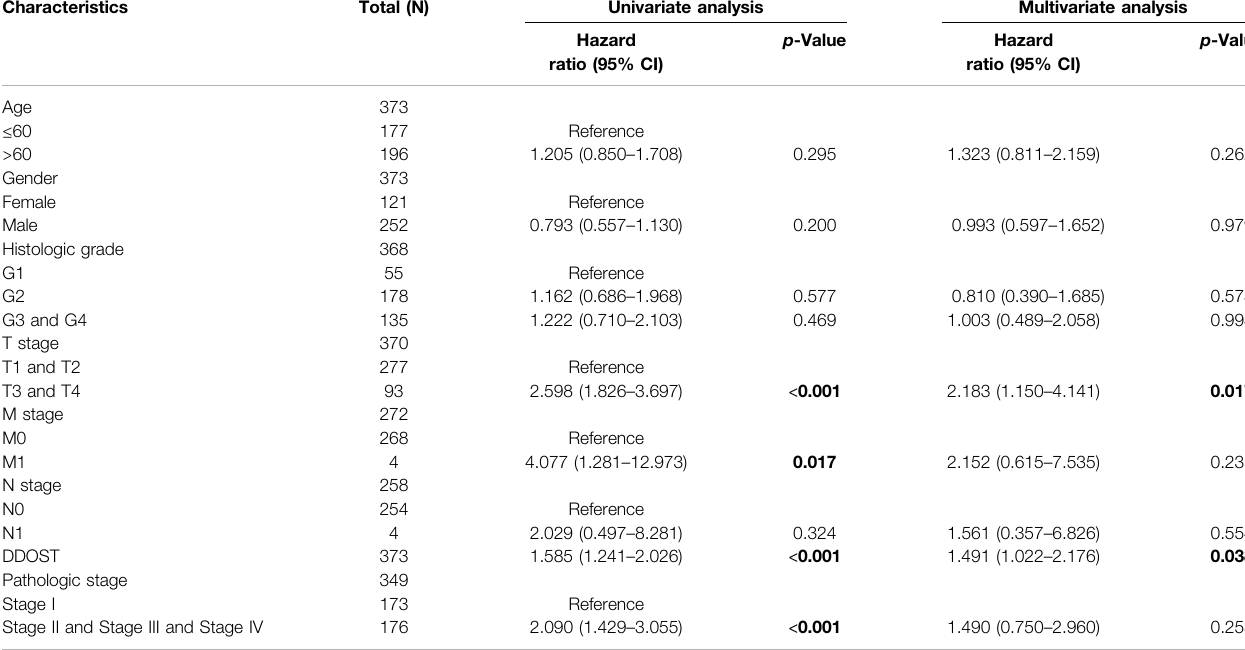
TABLE 4 | Univariate and multivariate analyses of clinical pathological parameters in HCC patients.